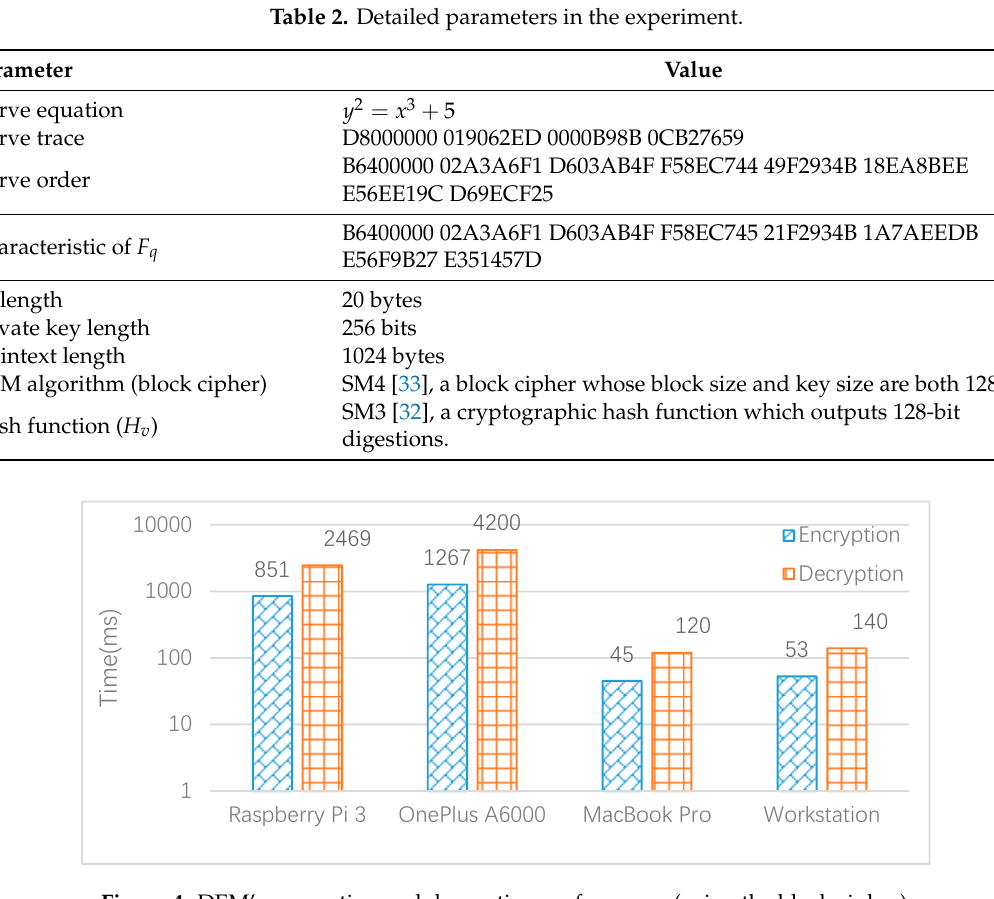
Table 2. Detailed parameters in the experiment.